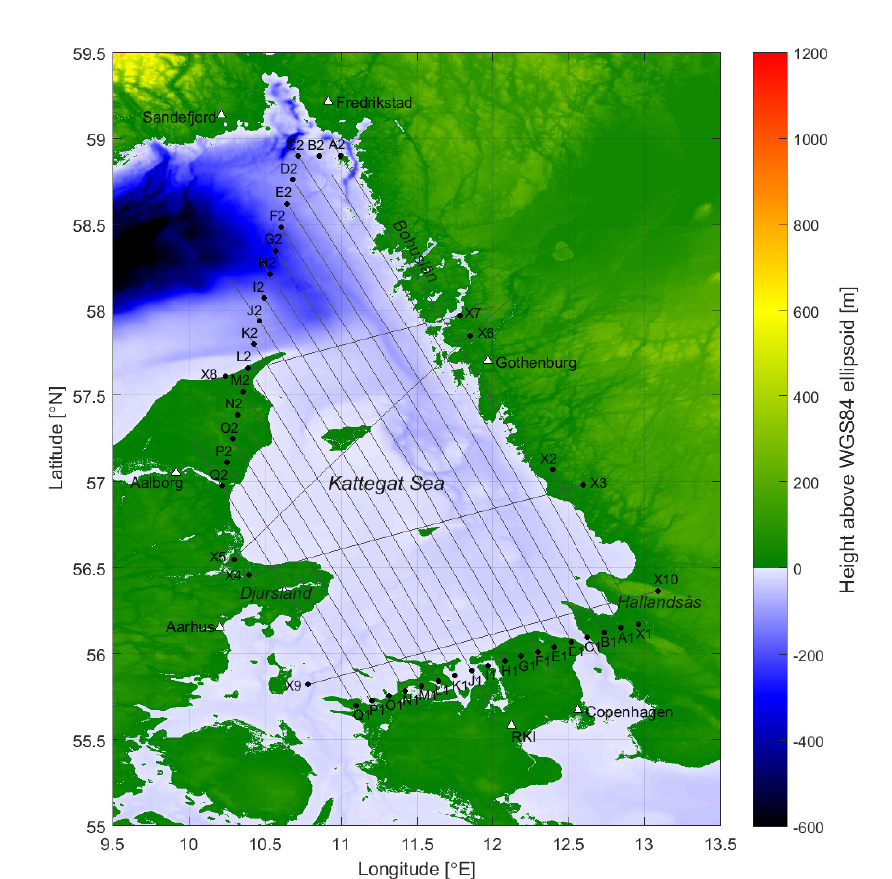
Figure 3. Overview of airborne survey with flight lines and waypoints. In the background is shown the topography and bathymetry model based on a merging of the 3 arc-second Shuttle Radar Topography Mission (SRTM) product [26] and bathymetry from the European Marine Observation and Data Network (EMODNet) data portal, see Appendix